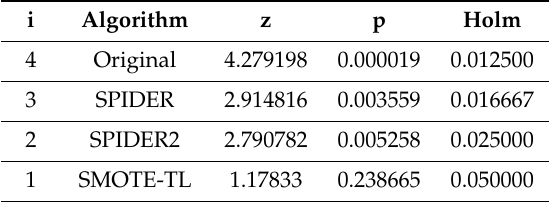
Table 27. Results of the Holm test comparing the performance of the SNDAM classifier after hybrid algorithms. The test rejects the hypothesis having an unadjusted p -value ≤